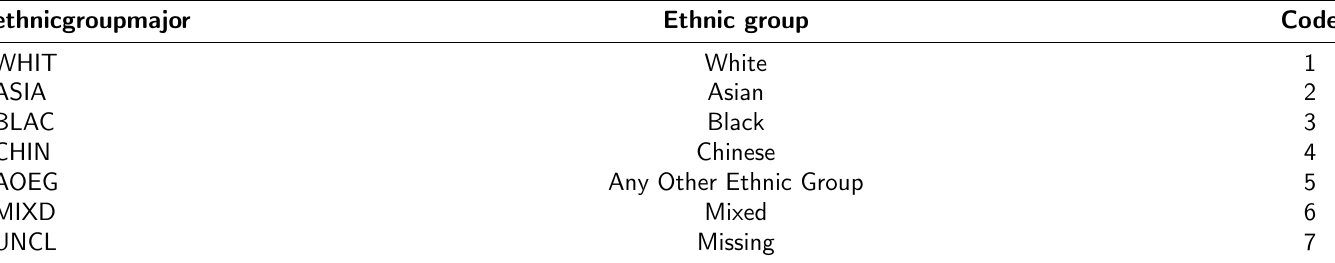
Supplementary Table 4.2: Classification of ethnic group with the ethnicgroupmajor variable